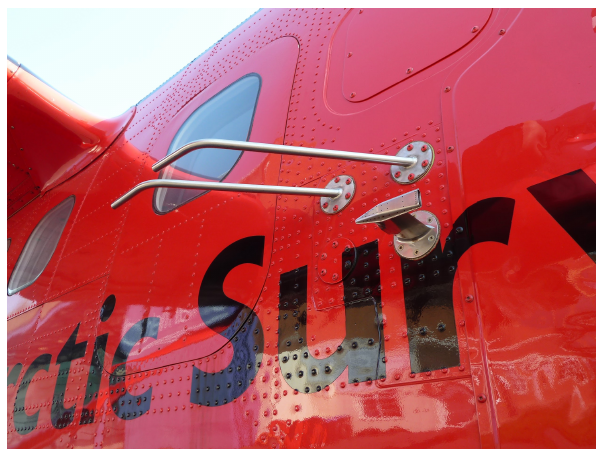
Figure A1. Photo of the rear-facing chemistry inlets on the BAS Twin Otter aircraft.